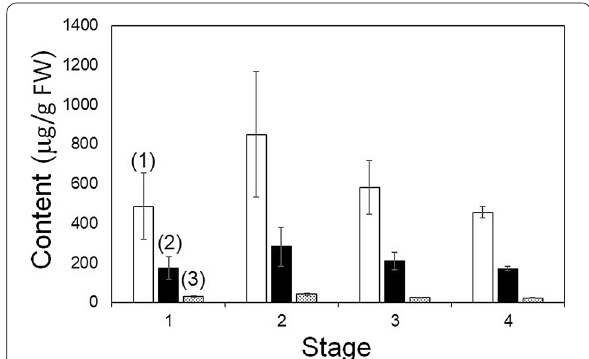
Fig. 4 Content of three catechol‑type lignans found in the seed coat at the different developmental stages. (1) Isoamericanol A, (2) americanol A, and (3) 3, 3 ′ ‑bisdemethylpinoresinol. The data represent the mean of four independent measurements (mean SE). Stage 1 ± (immature green): green fruits about 4.5 cm in diameter, 4 months after anthesis. Stage 2 (mature green): green fruits about 6 cm in diameter, 5 months after anthesis. Stage 3 (turning): red‑brown fruits about 6 cm in diameter, 5 months after anthesis. Stage 4 (over ripe): brown fruit about 6 cm in diameter, 5 months after